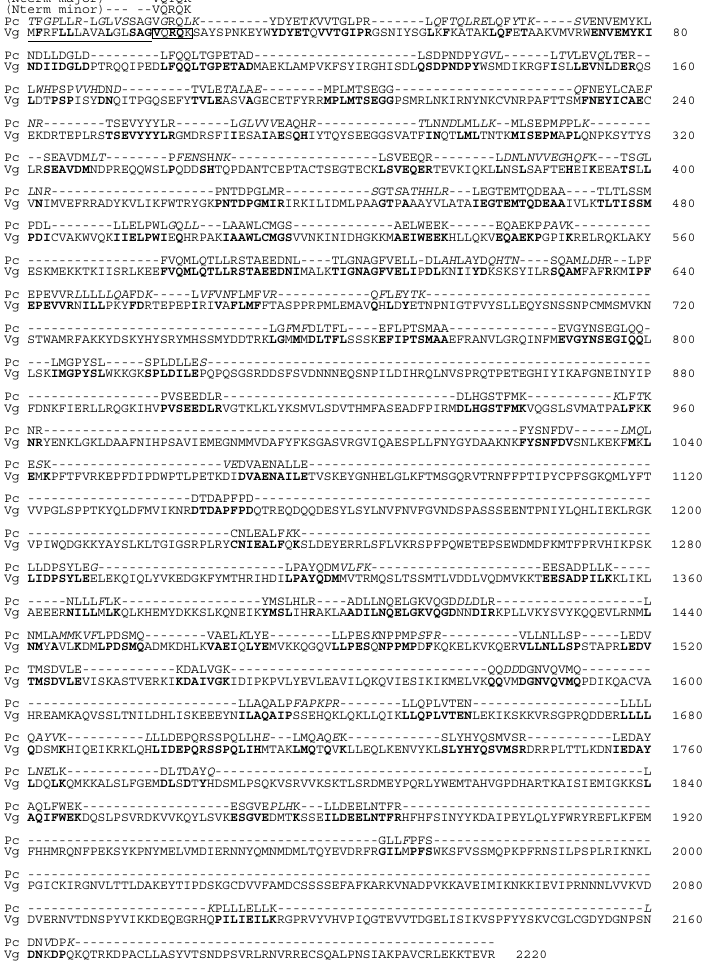
Figure 2. Sequence comparison between the fragments of pectenovarin and vitellogenin. Peptide fragments obtained by de novo LC-MS/MS analysis of pectenovarin were aligned to the sequence of vitellogenin from M . yessoensis . Boldface letters indicate exact-match residues (note that L and I were regarded as the same residue). Italic letters are unmatched residues. The boxed sequence corresponds to the N-terminal sequence shown by Edman degradation of native pectenovarin (Nterm major or minor). The underline indicates the predicted cleavable signal peptide (16 residues) [10,11]. Pc: pectenovarin (MS sequencing fragments), Vg: vitellogenin of M. yessoensis (AGE13945.1).